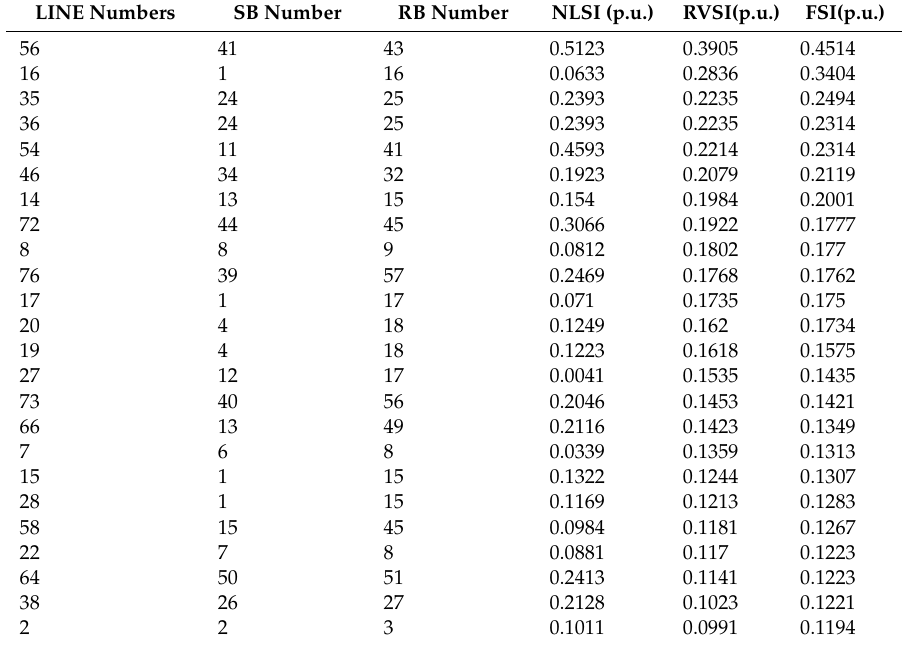
Figure 4. NLSI, RVSI and FSI values of all lines in IEEE-57-bus system. Table 3. NLSI, RVSI and FSI Values of top 25 lines in IEEE-57-bus system.